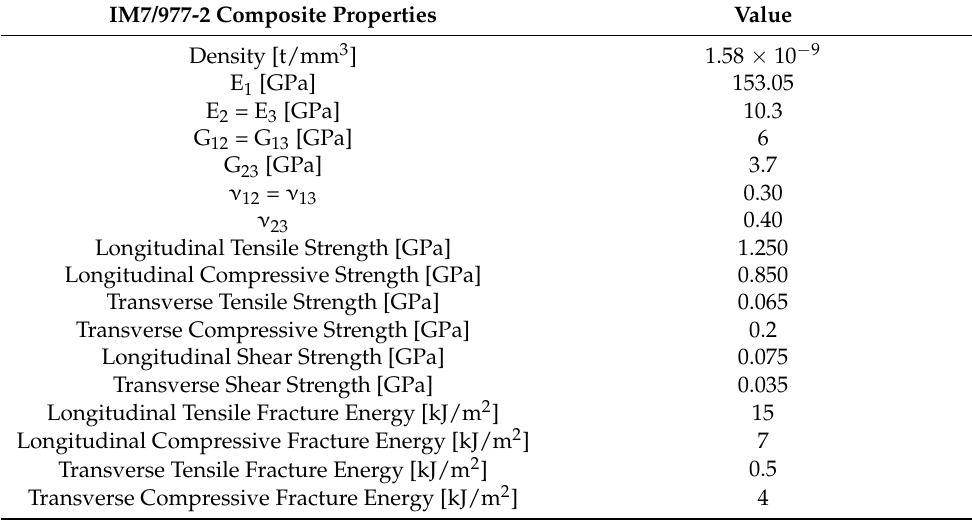
Table 4. Composite material IM7/977-2